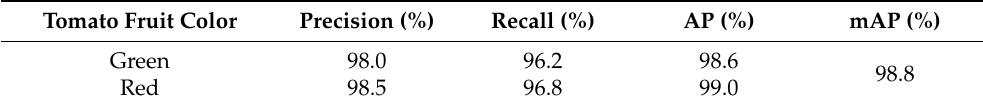
Table 4. Detection results for tomato fruit using SM-YOLO model.